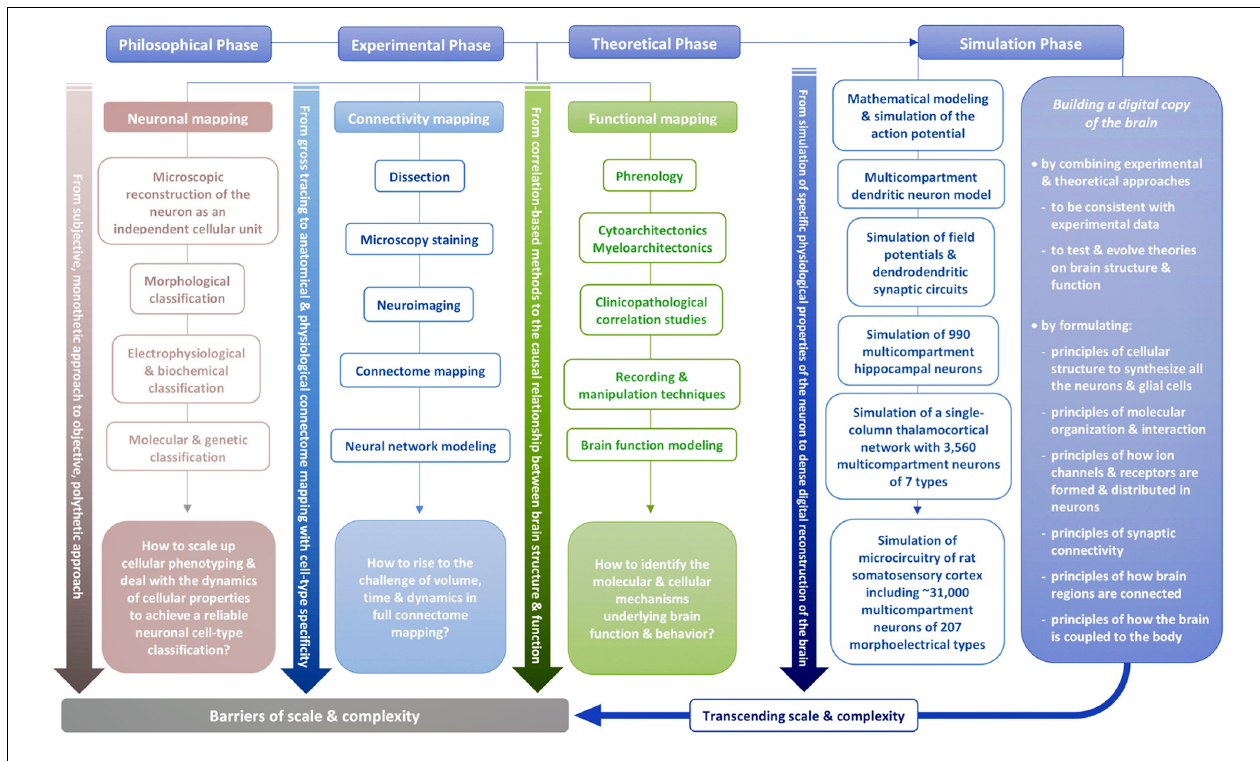
FIGURE 4 | Transcending scale and